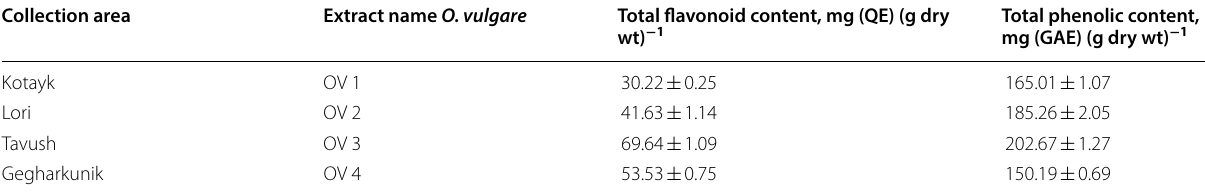
Table 1 Total flavonoid and phenolic contents of O. vulgare extracts